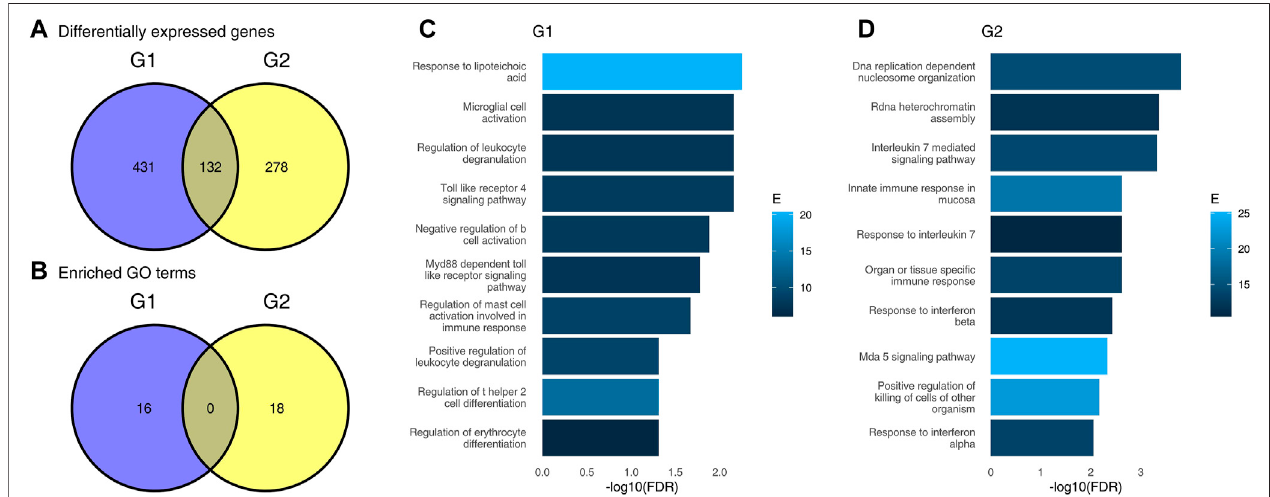
FIGURE1 | Results of differential geneexpression analysisand gene set enrichmentanalysisusing anincorrect approach. (A) , Venn diagram showing numbers of differentially expressed genes (DEG) in each of the two groups, G1 and G2; (B) , Venn diagram showing numbers of signi fi cantly enriched GO terms in each of the two groups; (C) resultsofgenesetenrichmentanalysisforgenes “ speci fi c ” togroupG1; (D) ,resultsofgenesetenrichmentanalysisforgenes “ speci fi c ” togroupG2(onlytop 10 terms are shown).